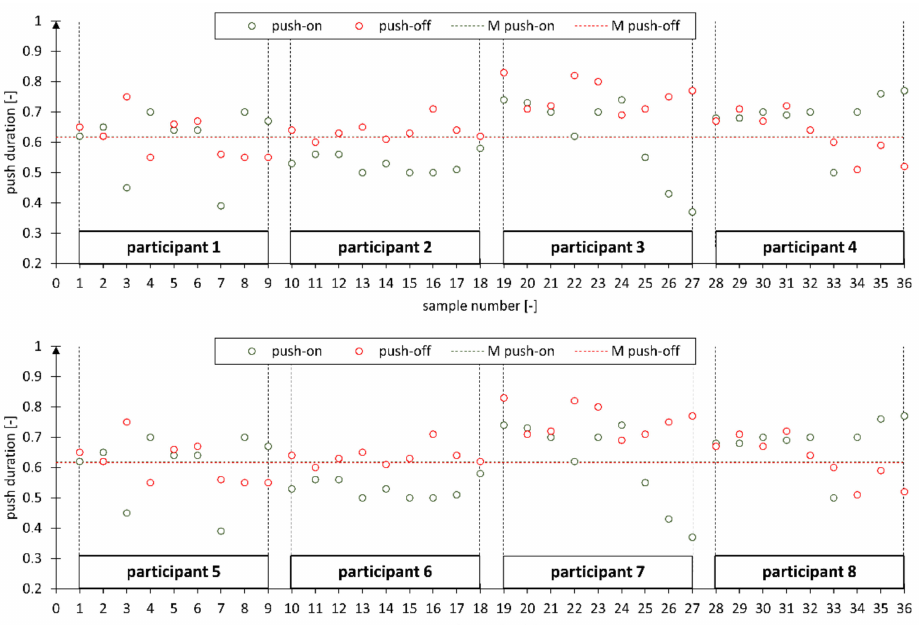
Figure 7. The diagram of the push phase share in the propelling cycle for all the analyzed measurement tests, where push-on—a push phase share with the activated anti-rollback system, push-o ff —a push phase share with the deactivated anti-rollback system, M push-on—an average push phase share for all the measurement tests with the activated anti-rollback system, M push-o ff —an average push phase share for all the measurement tests with the deactivated anti-rollback system.